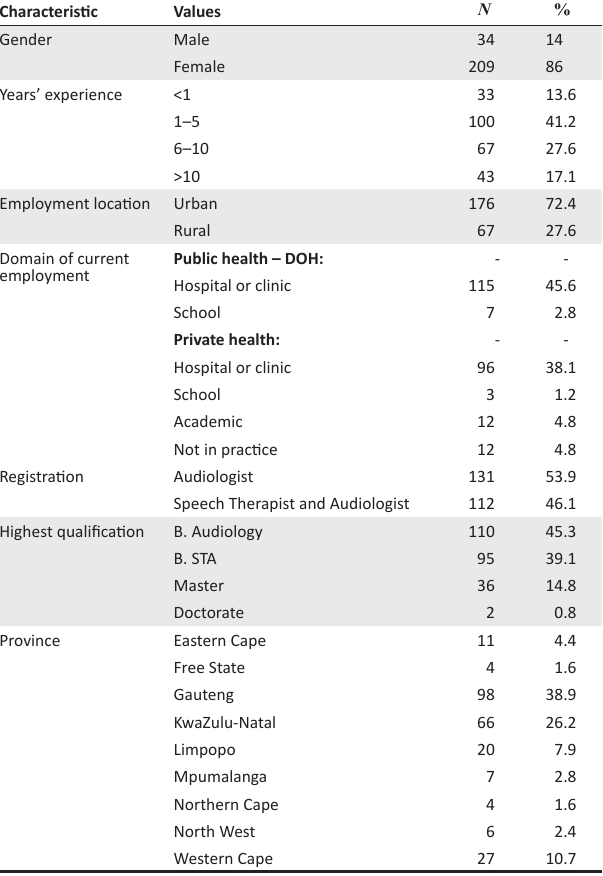
TABLE 1: Biographical details ( n =